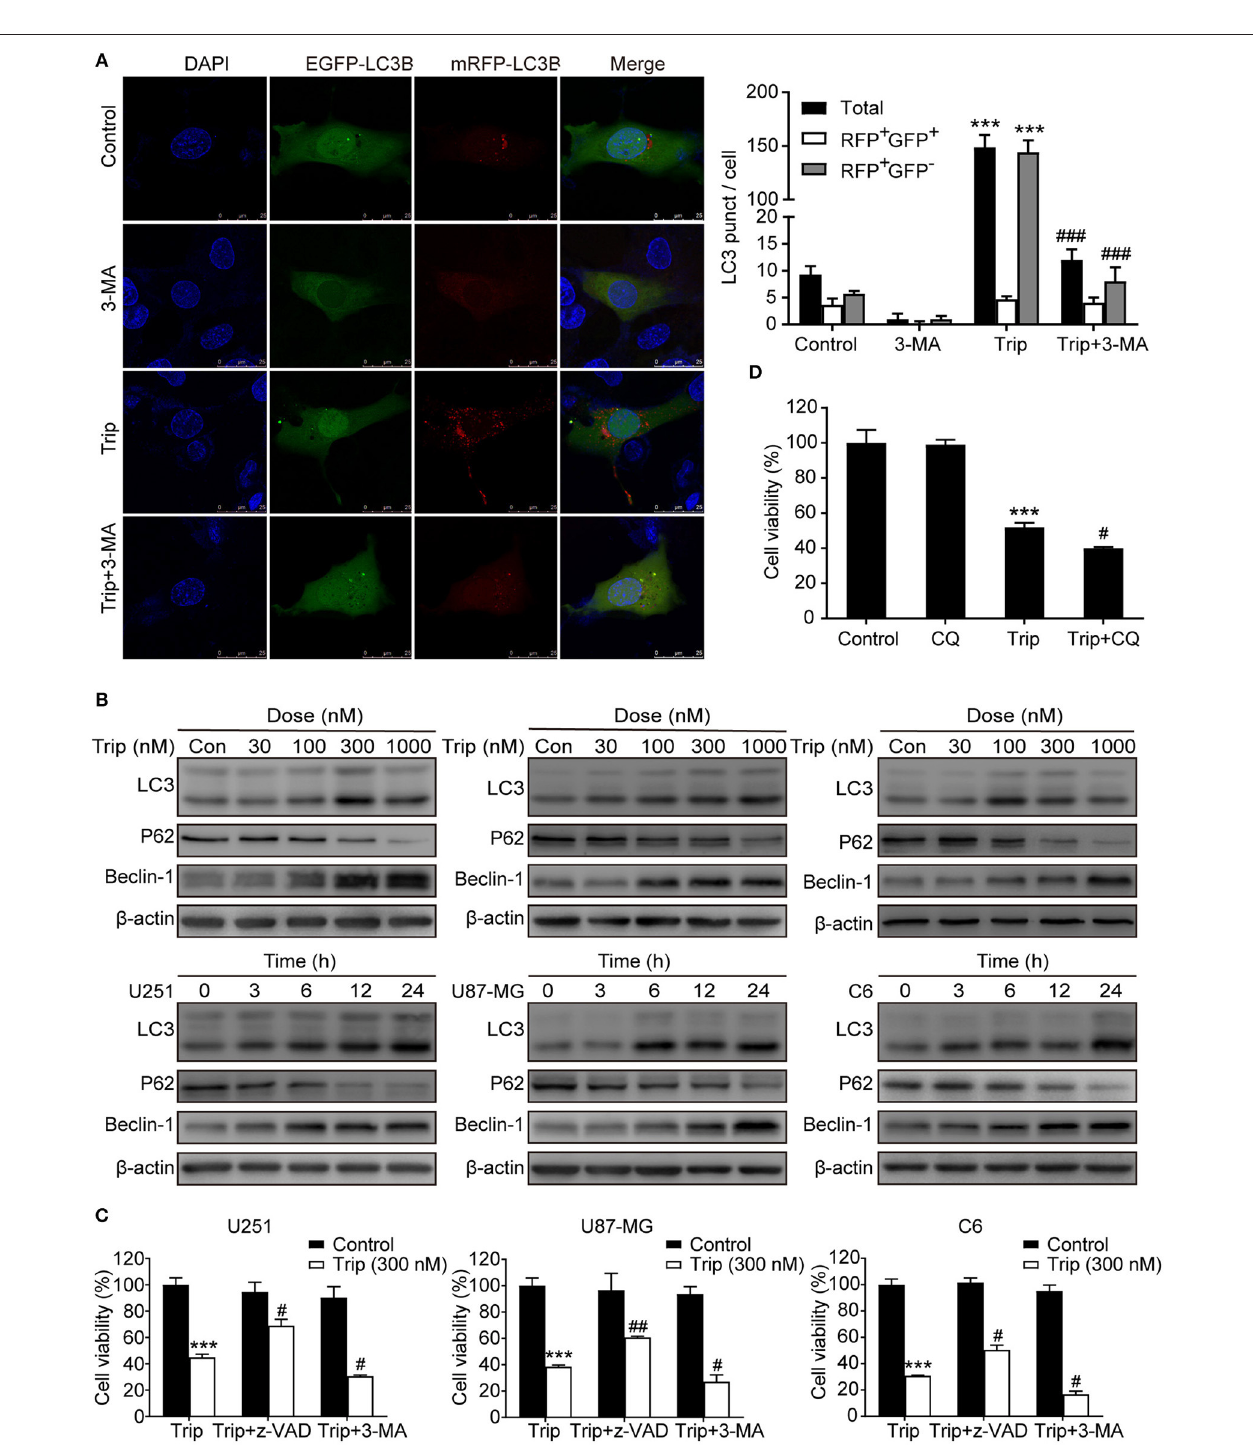
FIGURE 3 | Triptolide induced protective autophagy in glioma cells. (A) Cells stably expressing mRFP-EGFP-LC3B were pretreated with 3-MA (3mM) for 2h, followed by treatment with triptolide (150nM) for an additional 24h. Representative fluorescent images were photographed by laser scanning confocal microscopy. Scale bars = 25 µ m. (B) Cells were treated with the indicated concentrations of triptolide for 24h or incubated with triptolide (300nM) for 0–24h, and the autophagy-related proteins LC3, p62, and Beclin-1 were analyzed by western blotting. (C) U251, U87-MG, and C6 cells were pretreated with 3-MA or z-VAD (30 µ M) for 2h, followed by treatment with triptolide (300nM) for an additional 24h. Cell viability was determined by a CCK8 assay. (D) U251 cells were pretreated with CQ (20 µ M) for 2h, followed by treatment with triptolide (300nM) for an additional 24h. Cell viability was determined by a CCK8 assay. The data are presented as the means ± SD ( n = 3). *** P < 0.001, significantly different compared with the untreated control group. # P < 0.05, ## P < 0.01, ### P < 0.001 significantly different compared with the triptolide treatment group.